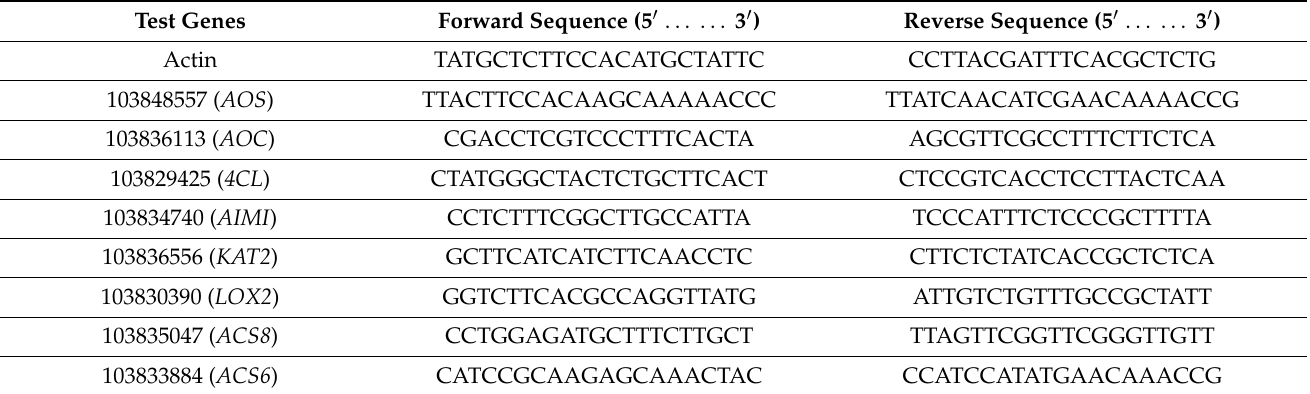
Table 2. Primers of all test genes JA, SA,